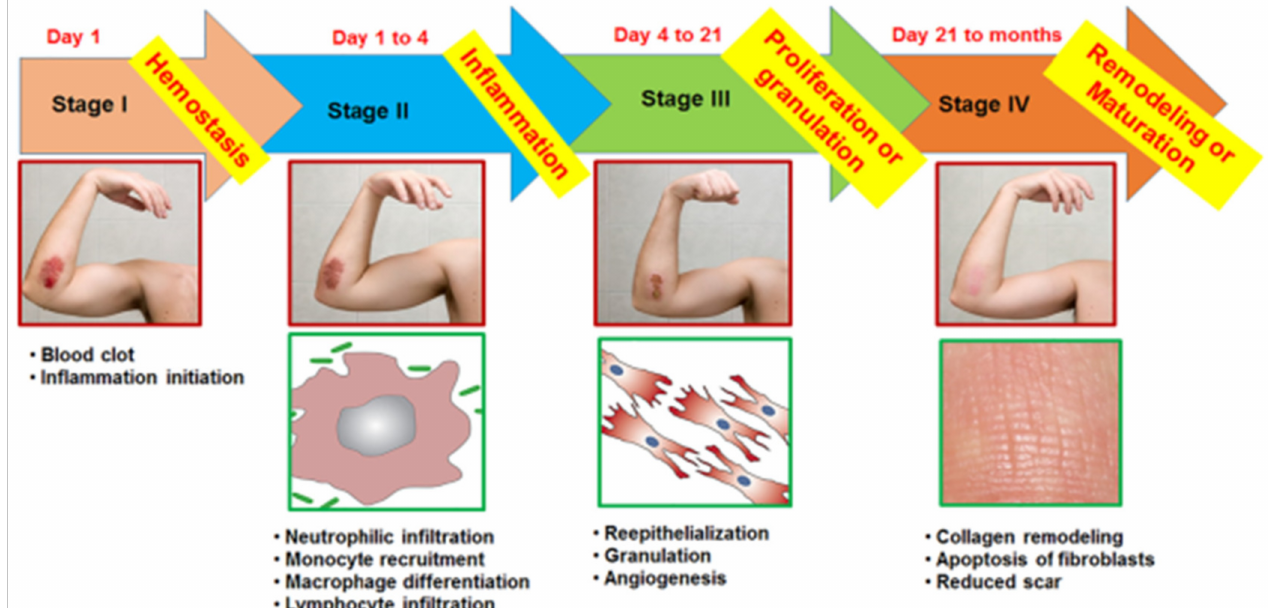
Figure 1. The basic stages of wound healing. Stage I is the homeostasis phase and it occurs immediately after injury. Stage II is inflammation, where a number of enzymes and growth factors are produced to fight off infection. Stage III represents the proliferation stage; this is where extracellular matrix (ECM) and collagen are produced, leading to re-epithelisation. The final stage, stage IV, is the remodelling stage, where wound closure occurs. Reprinted with permission from Elsevier